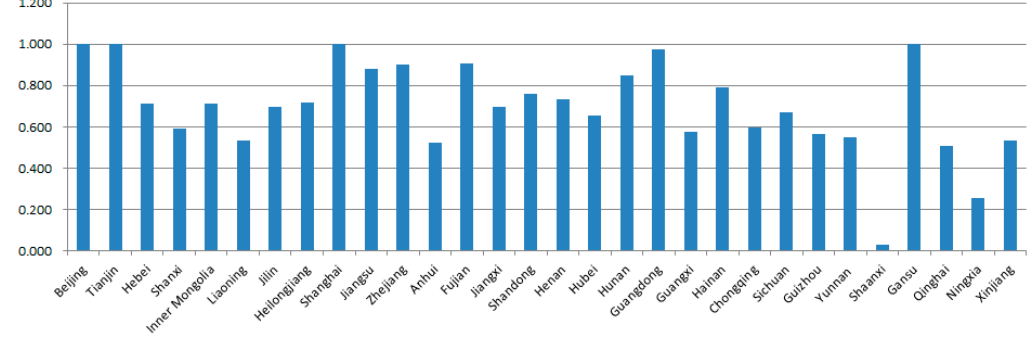
Figure 3. Average environmental efficiency under natural disposability and constant RTS.